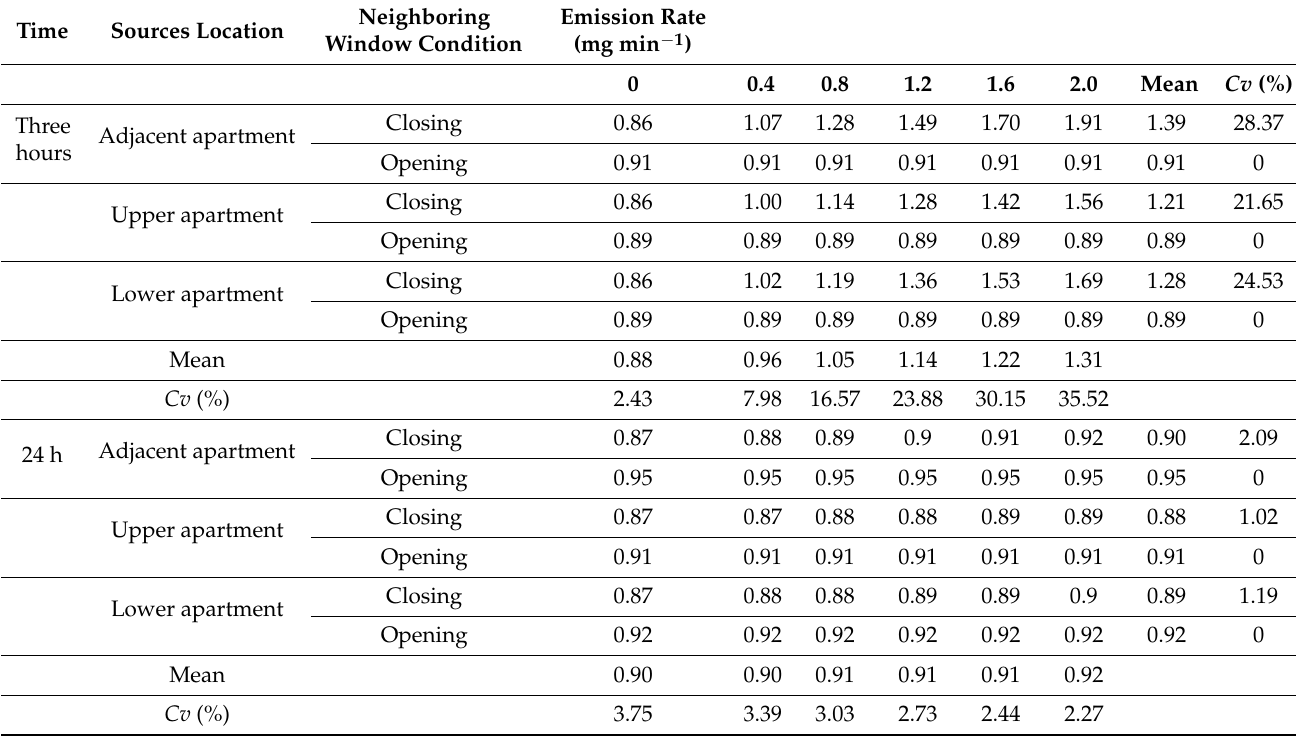
Table 3. Penetration factor estimated by modeling indoor concentration and outdoor value under 4 Pa pressure difference with five generation rates during two periods. Cv is the coefficient of variation of the